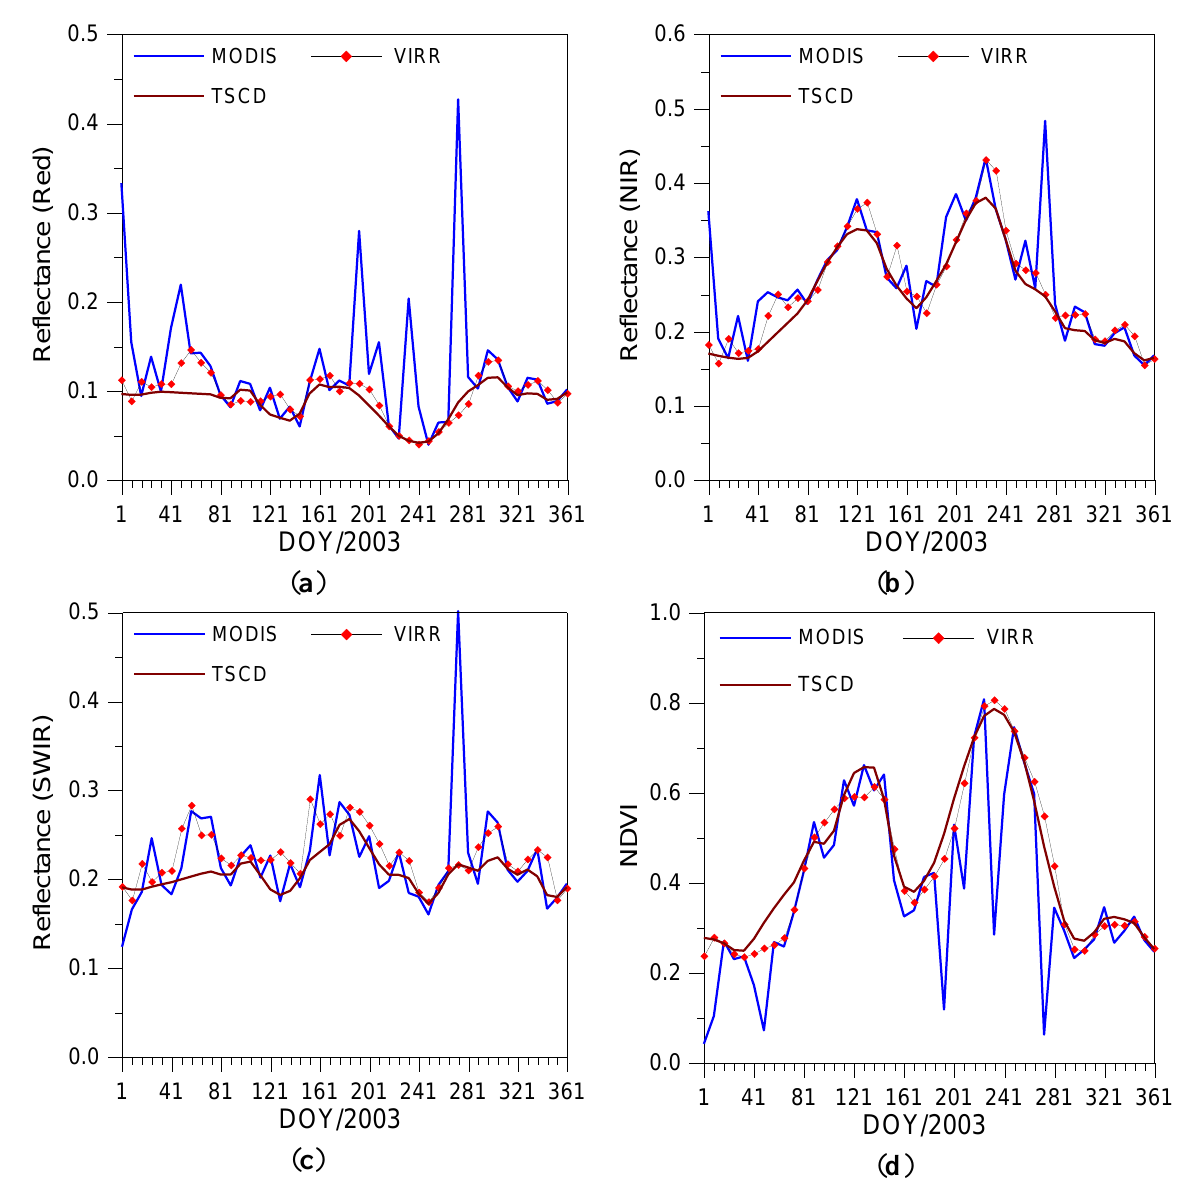
Figure 7. Time series of surface reflectance and NDVI from MOD09A1, the VIRR and TSCD algorithms for the center pixel of the Yucheng site in 2003. ( a ) surface reflectance in the red band; ( b ) surface reflectance in the NIR band; ( c ) surface reflectance in the SWIR band; ( d )